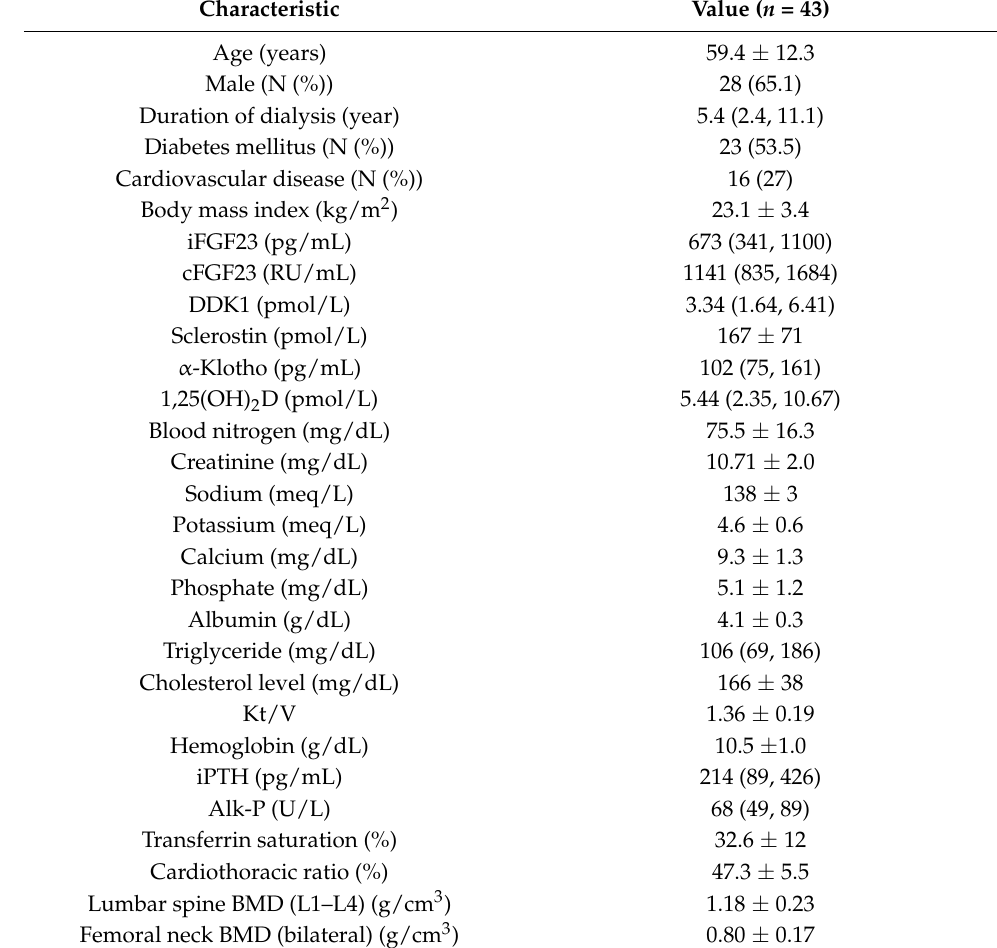
Table 1. Characteristics of the study